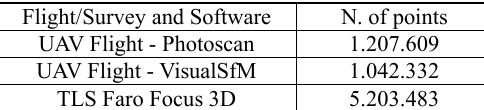
Table 2: Flights parameter